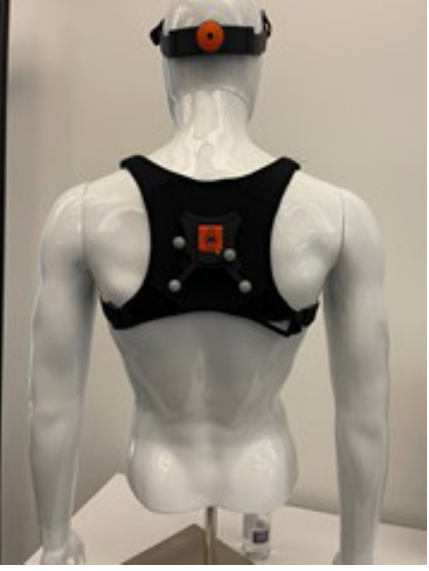
Figure 1. IMU sensors’ configuration for cervical spine motion